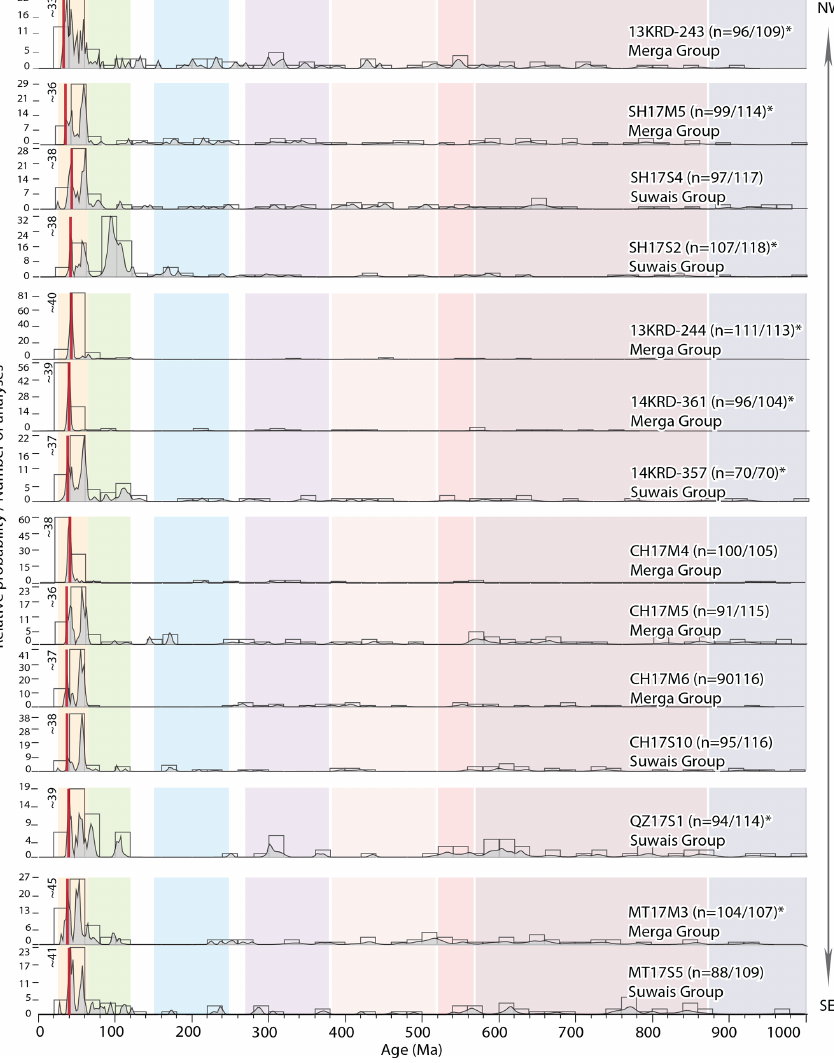
Figure 8. Detrital zircon U–Pb age distribution plots for the Red Beds Series units of the Suwais and Merga groups depicted as probability density plot (PDP; bandwidth = 20, bin width = 20) and age histograms (Vermeesch, 2012). Dark-red vertical bars delineate the youngest age peak ( ≥ 3 grains). Colored shading represents key source terrane age components (see Fig. 7 for legend). Samples with an asterisk are new samples. Published samples are from Koshnaw et al. (2019). Sample sets are separated by a white space according to their localities. Sample locations are shown in Fig.